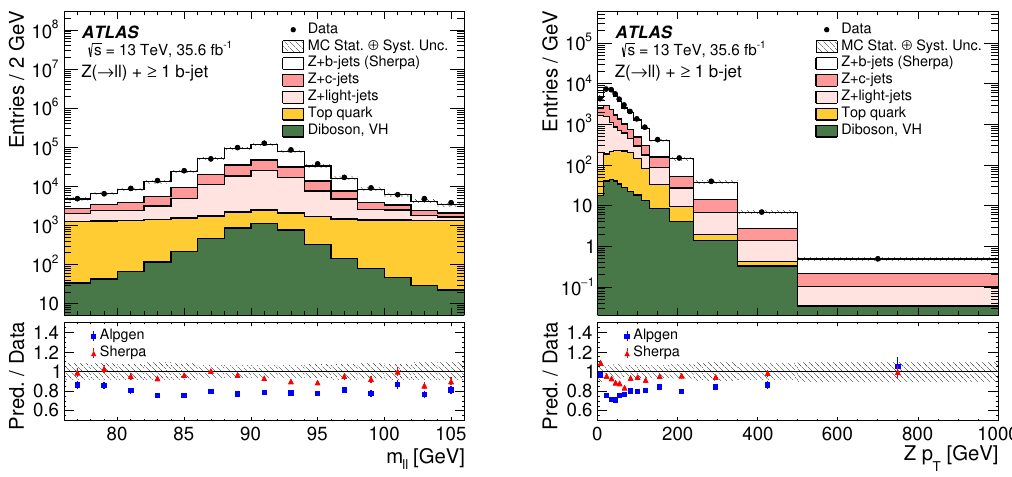
Figure 4 . Distribution of events passing the signal selection as a function of m ‘‘ (left) and p T ;Z (right) for events with at least one b -jet. The lower panels display the ratio of the predictions for signal plus background to data using either Sherpa (red) or Alpgen + Pythia6 (blue) as the signal simulation. The statistical uncertainty of the data is shown as black error bars and the total uncertainty of the prediction as a hatched band. The latter consists of the statistical uncertainty and all systematic uncertainties from the